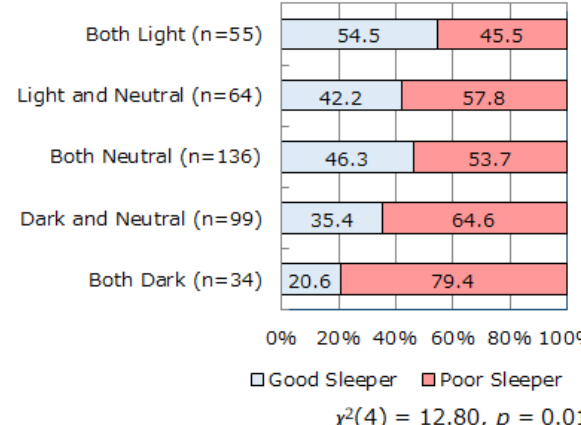
Figure 5. The relationship between the combination of lunar phase (light, dark, neutral periods) in the two most recent menstruation onsets and subjective sleep quality among participants with mean menstrual cycle = 29.5 ± 1 days ( A ) and those with mean menstrual cycle greater than or less than 29.5 ± 1 days ( B ). There was no statistically significant relationship between lunar phase and sleep quality among participants with a menstrual cycle of 29.5 ± 1 days ( A ). In contrast, there was a significant relationship between lunar phase and sleep quality, with a gradual change in lunar phase at the onset of menstrual cycle due to longer or shorter mean menstrual cycle length (B).